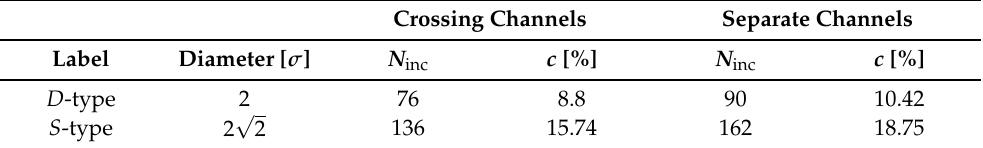
Figure 3. Illustration of different channel layouts studied on the basis of a 6 periodically doubled in each direction. The left part of the image shows the layout with nanochannels crossing each other. The right part presents the layout with separate nanochannels. The radii of the nanochannels are equal to σ ( D -type channels). The matrix particles (green spheres) were intentionally reduced in size to show the structure of the inclusions. Table 1. Detailed number of particles in nanochannels of different sizes and layouts. Differences between layouts are due to the number of shared particles in the crossing channels. The values vary with the total number of particles. The values presented are for the system of N = 864 particles, which corresponds to 6 6 6 f.c.c. × ×